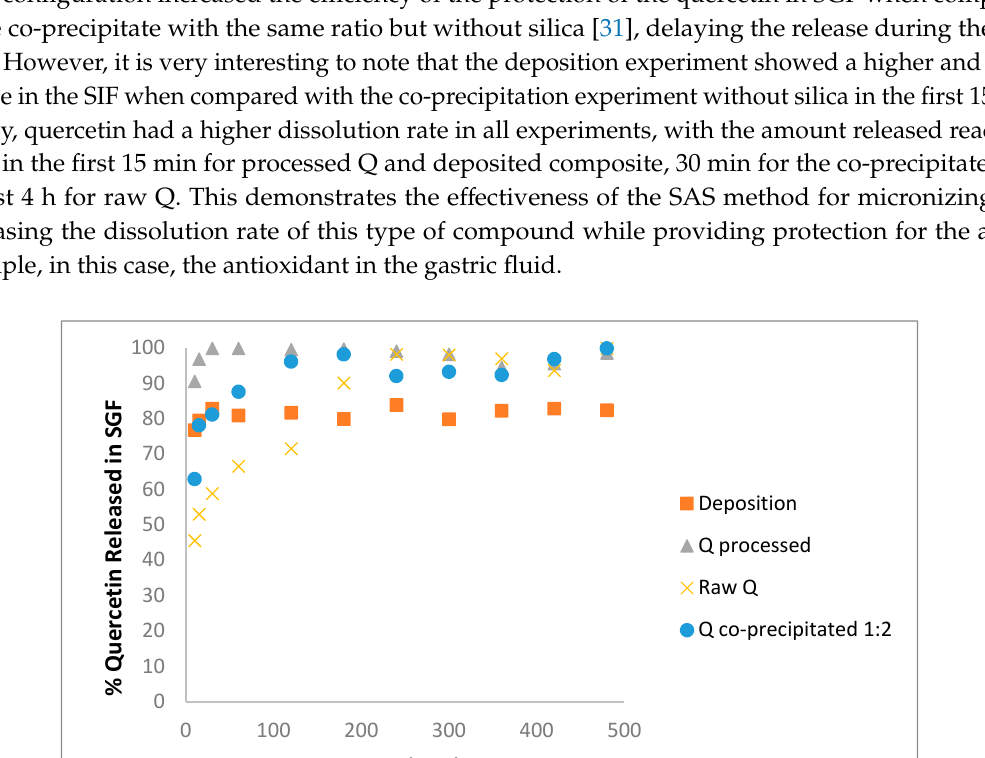
Table 2. Quantity of antioxidant in 5 mg of sample.